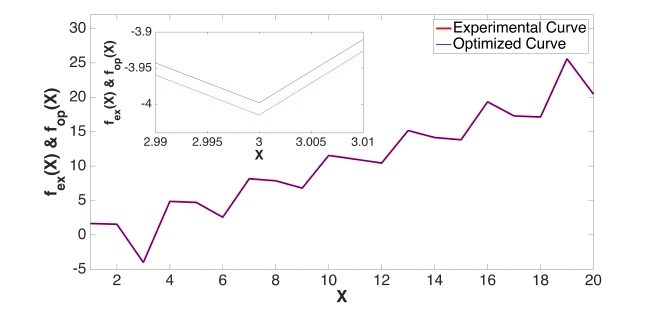
Figure 4. Case study 3.